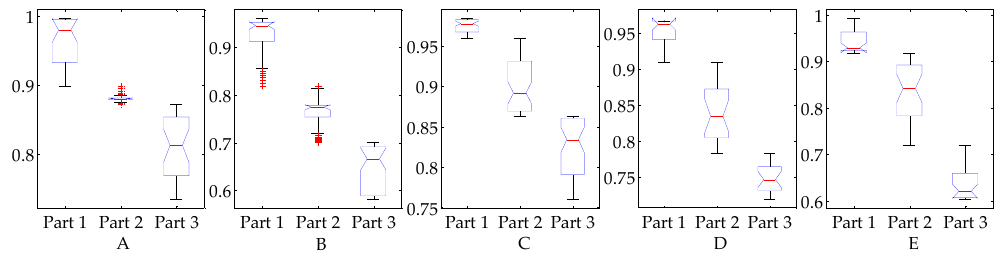
Figure 8. Boxplot of the three parts from five subjects. All the p values (ANOVA) are much smaller than 0.01.